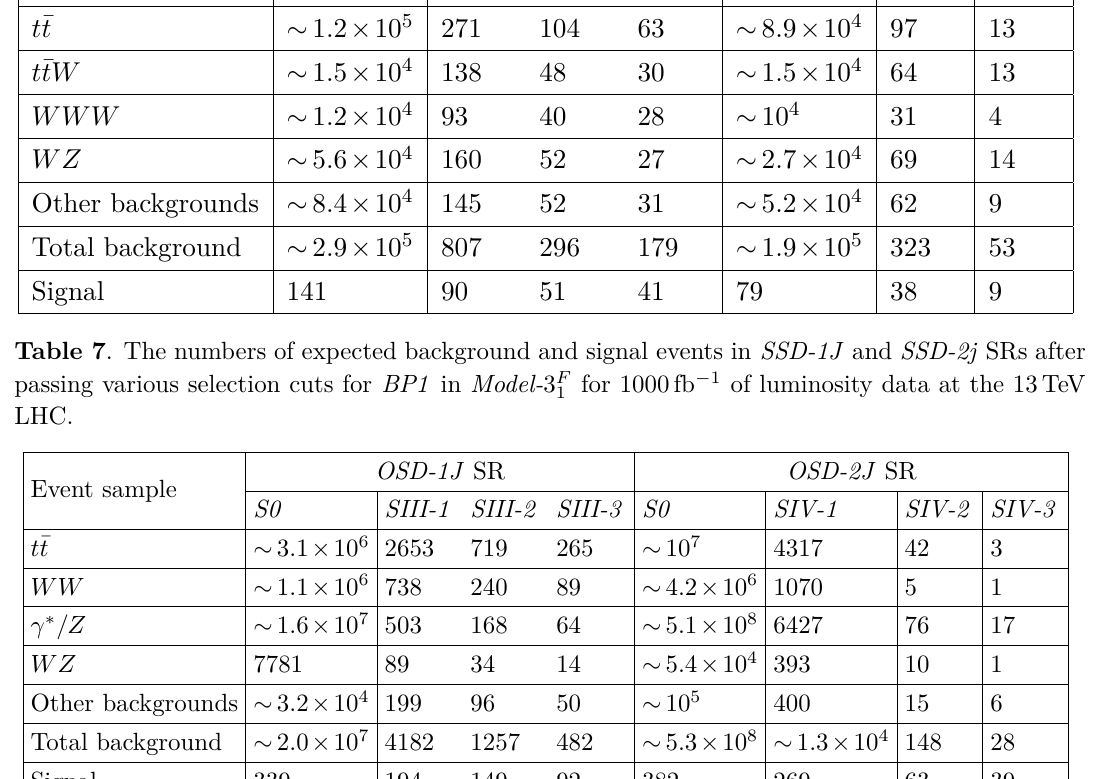
for 1000 fb − 1 of luminosity data at the 1